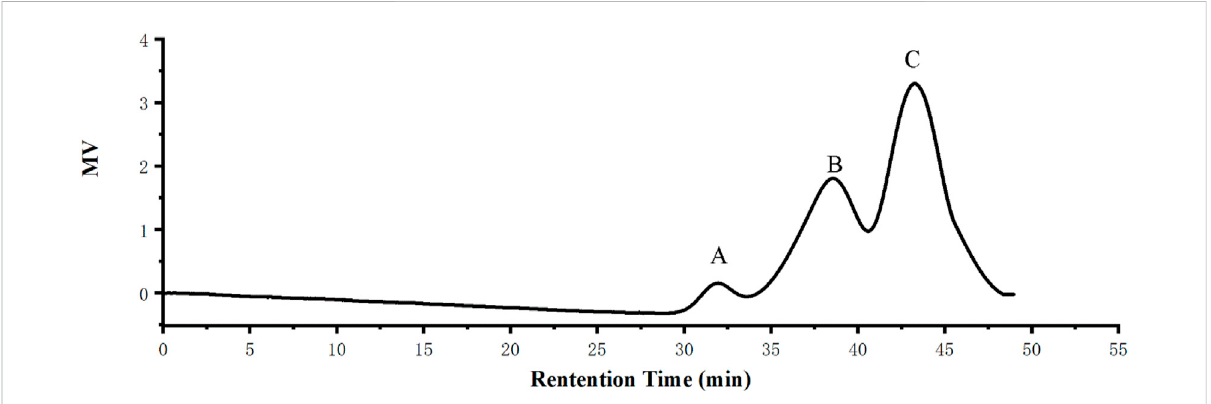
FIGURE 4 RFP consists of three polysaccharides of different molecular weights. (A) Molecular weight of 1,211.136 kDa with a peak area of 4.6% (w/w) (B) Molecular weight 64.677 kDa, 37% peak area (w/w) (C) Molecular weight 7.973 kDa, peak area 58.4%